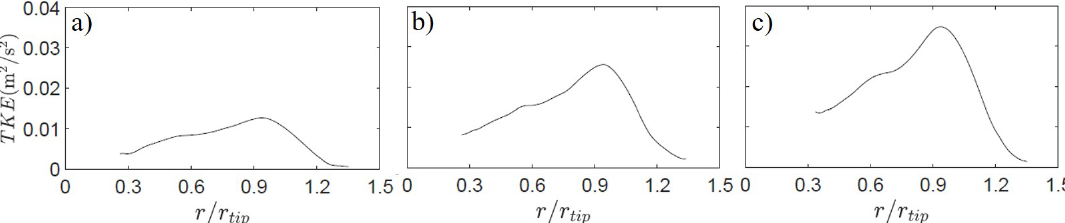
Figure 12. θ —averaged distributions of in-plane turbulence kinetic energy TKE at (cid:101) 3 = 0.75 mm for: